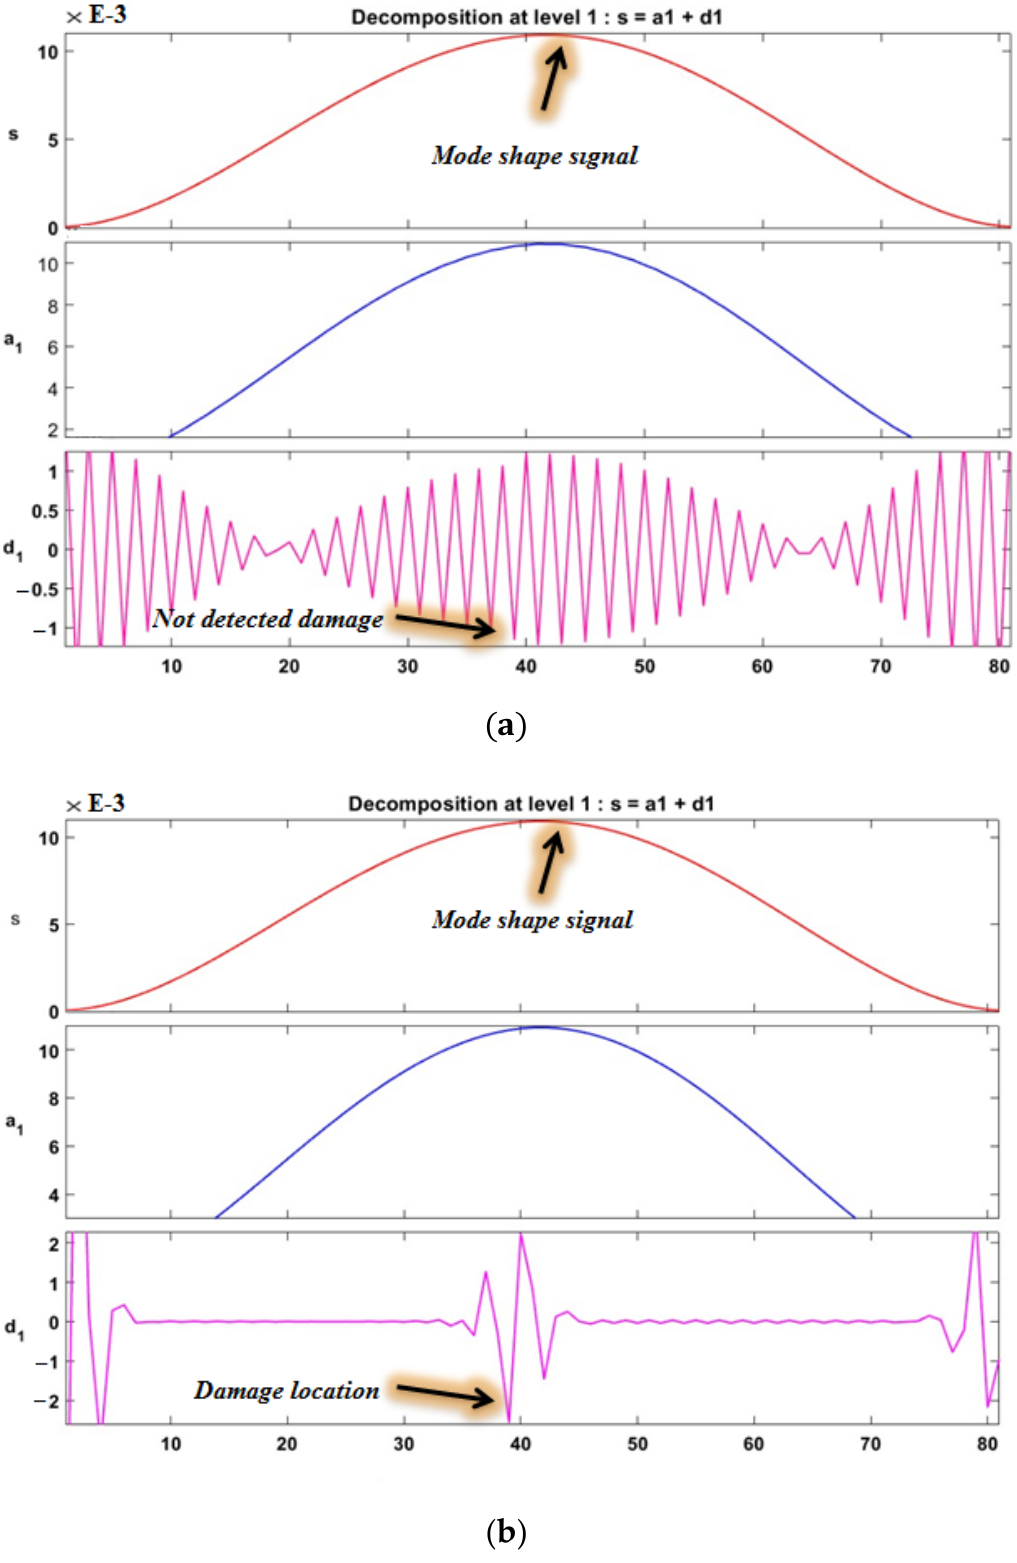
Figure 11. The effect of increasing the vanishing moments on the accuracy of damage detection by 1D-DWT from the quasi-Pearson-based coefficient extracted from intact and damaged mode shapes by 70% damage: ( 𝐚 ) vanishing moments = 2, ( 𝐛 ) vanishing moments = 5.